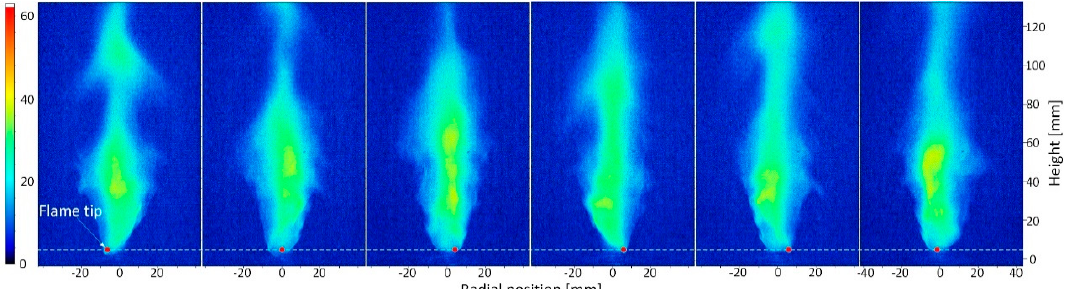
Figure 8. Typical flame instable behavior caused by a central fuel jet injection (the flame tip is moving circularly along the outer edge of the bluff-body).